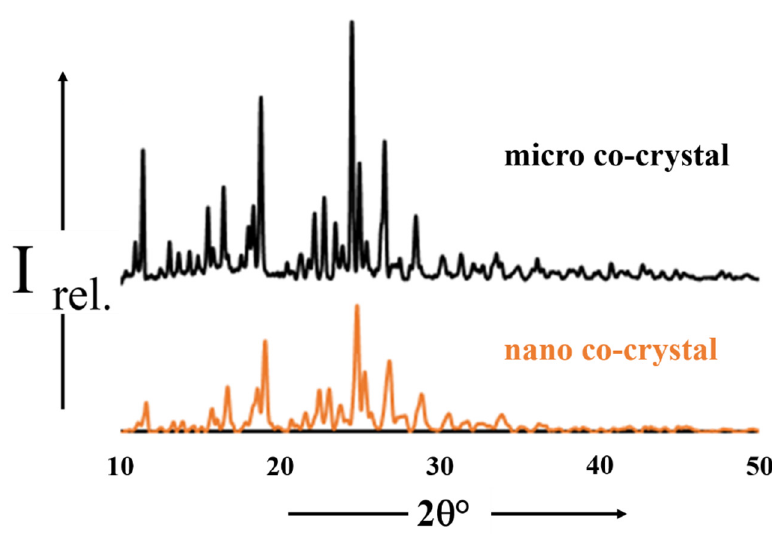
Figure 4. PXRD di ff ractograms for the micro (black) and nano co-crystals (orange). Figure 4. PXRD diffractograms for the micro (black) and nano co-crystals (orange).